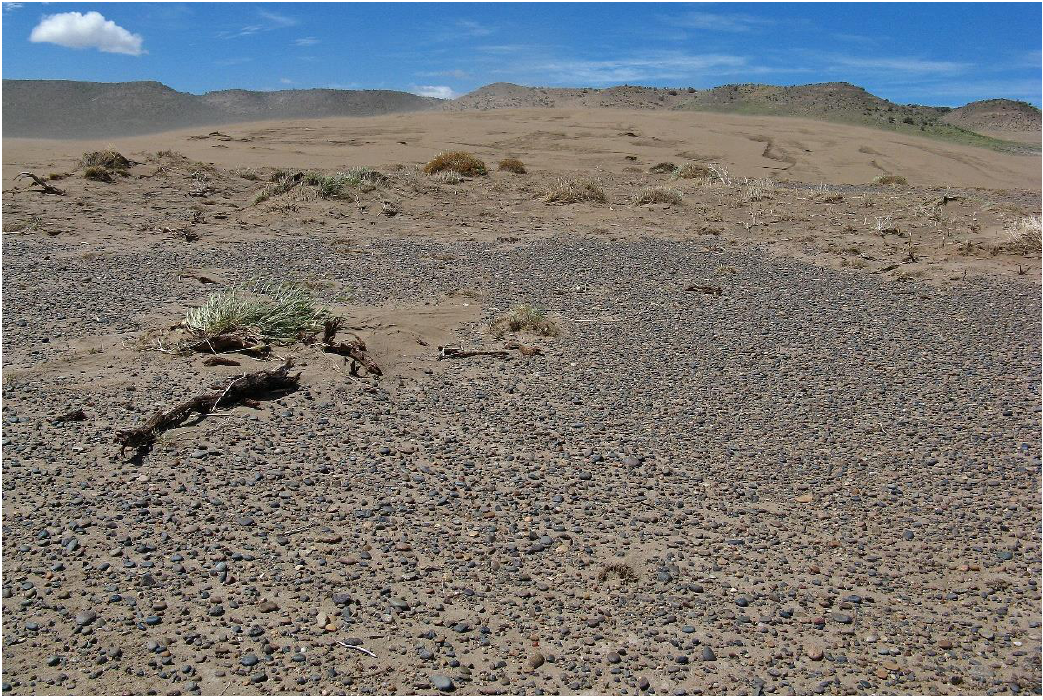
Figure 2. An example of a possible desert-like end stage: A desert pavement following strong wind erosion on previously vegetated land in Chubut Province, Patagonia, Argentina.